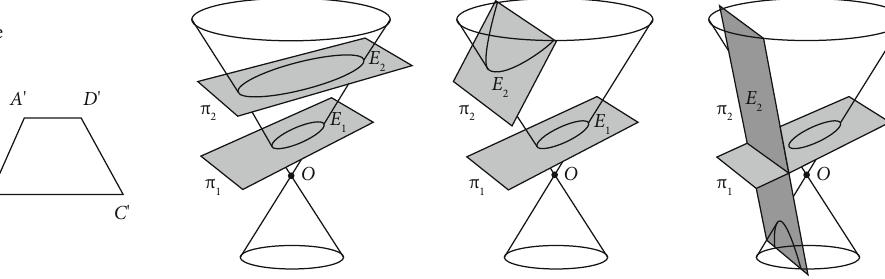
Figure 4: Projective transformation